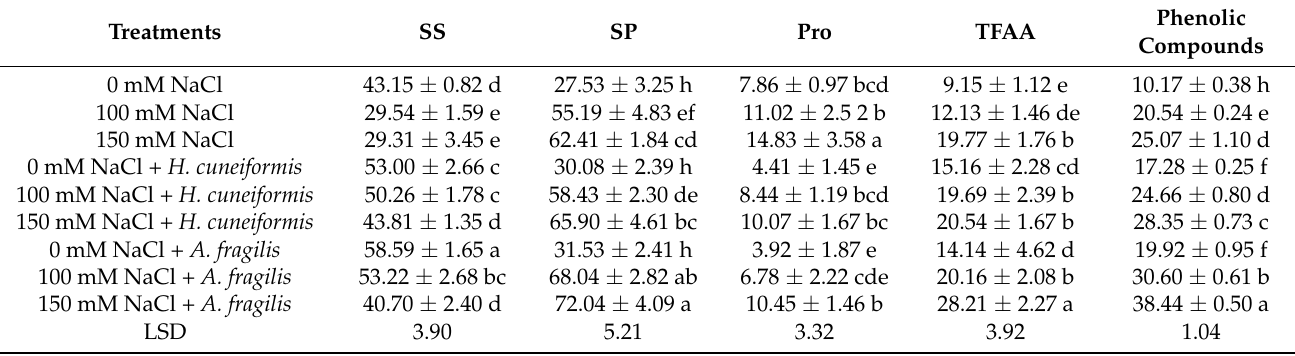
Table 2. The effect of salinity stress on soluble sugars (SS, mg g − 1 DW), soluble proteins (SP, mg g − 1 FW), proline content (Pro, µ g g − 1 FW), total free amino acids (TFAA, mg g − 1 FW) and phenolic compounds (nmol g − 1 FW) of wheat ( Triticum aestivum L.) primed with H. cuneiformis and A. fragilis extracts.